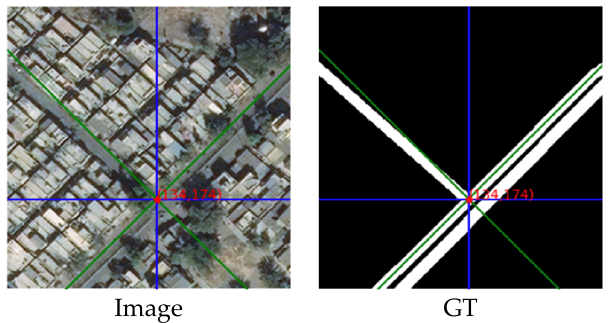
Figure 23. The image and its ground truth.